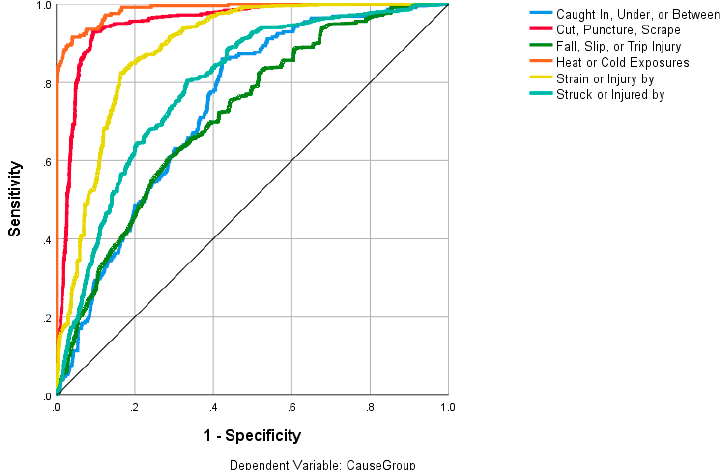
Figure 6. ROC for RBF Model (Test Data).